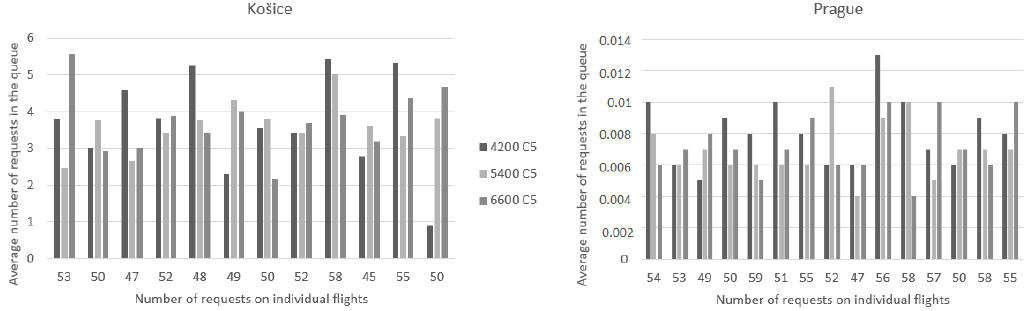
Figure 7. The average number of requests in the queue when handling time changes.